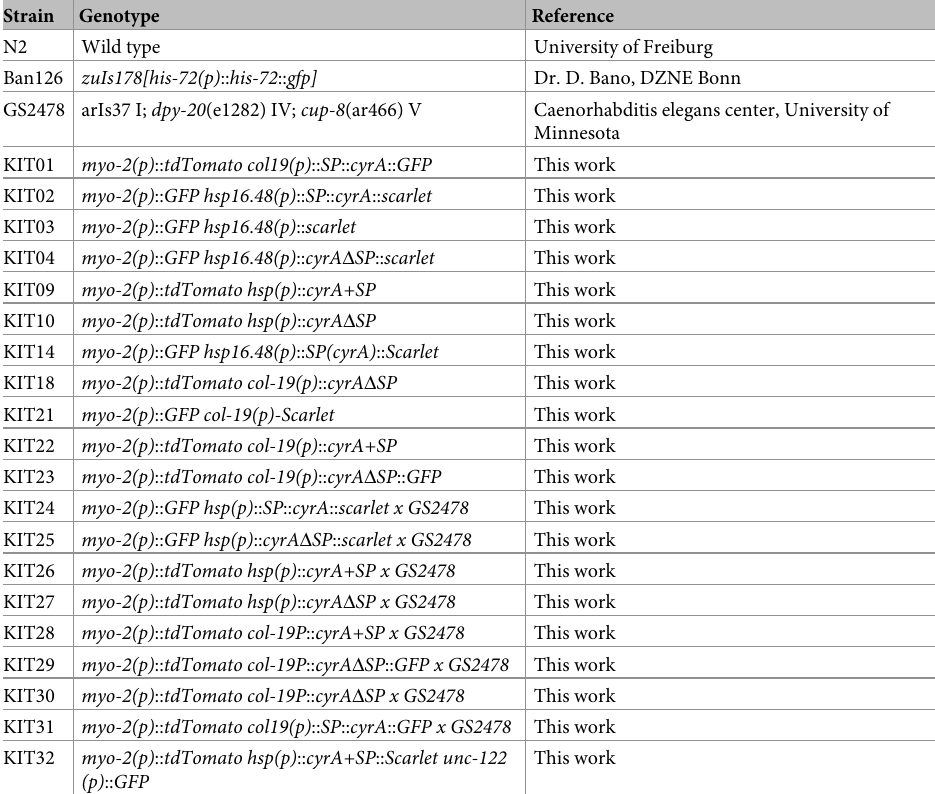
Table 1. C . elegans strains used in this study. Strain